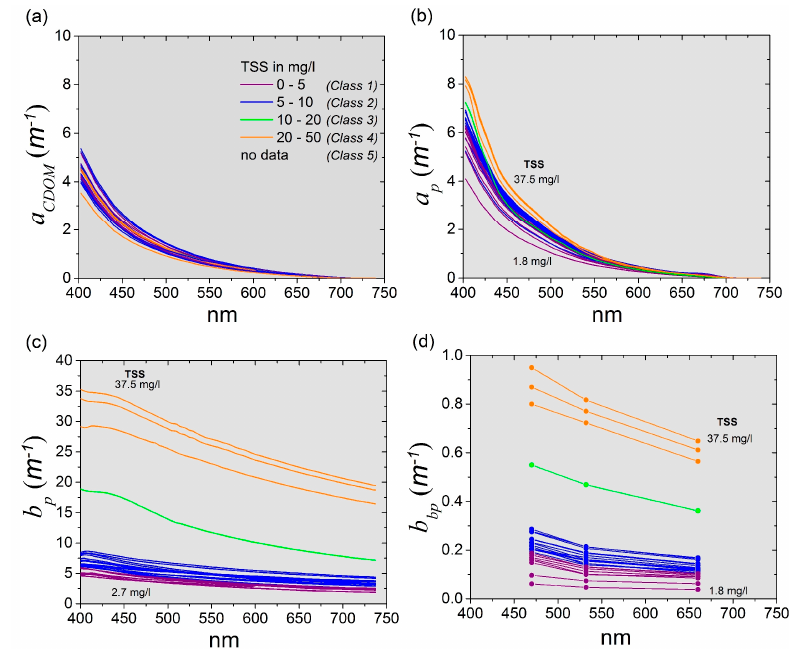
Figure 5. Spectral distribution of in situ IOPs for different water classes: absorption by particles ( a ) and CDOM ( b ); and particulate scattering ( c ) and backscattering ( d ). Gray scale curves represent the five classes of water as explained in the section above. Note that Class 5 is not shown in ( b – d ) due to lack of data.